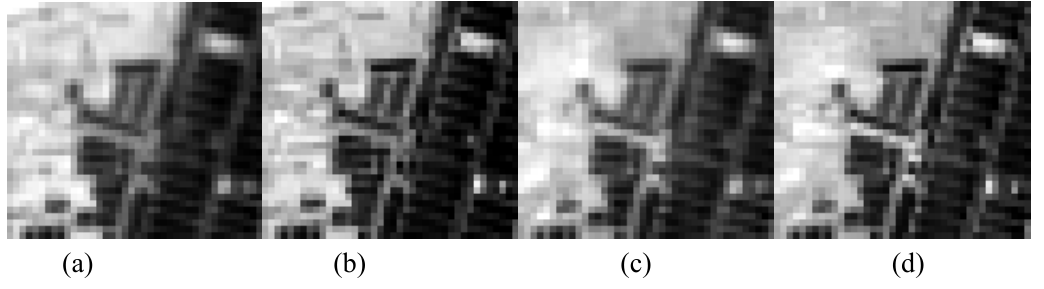
Figure 2 . Visual comparison of the magnification of a detailed region circled by the white rectangle in Figure 1. (e)-(h): (a) and (b) are band 94 of original Hyperion data and simulated Hyperion data; (c) and (d) are band 148. The texture of the pond, the pattern of vegetation distribution on the left part of this region, several little bright objects on the lower right part, the border between pond and land keep consistent and look same between original data and simulated data. Original data is a bit vaguer because of the resampling method in geometrical correction.